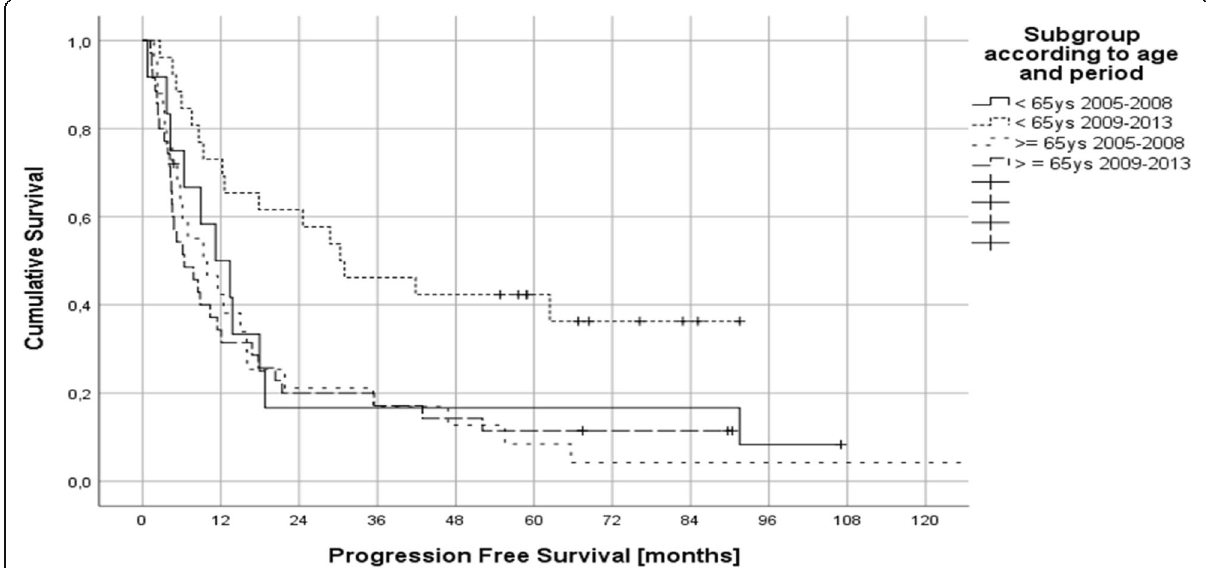
Fig. 2 Progression free survival according to age and treatment period (group A: < 65 ys 2005 – 2008 received intrathecal liposomal Ara C; group B: < 65 ys 2009 – 2013 received intraventricular therapy via Ommaya reservoir [25/26 patients]; group C: ≥ 65 ys 2005 – 2008 received intrathecal